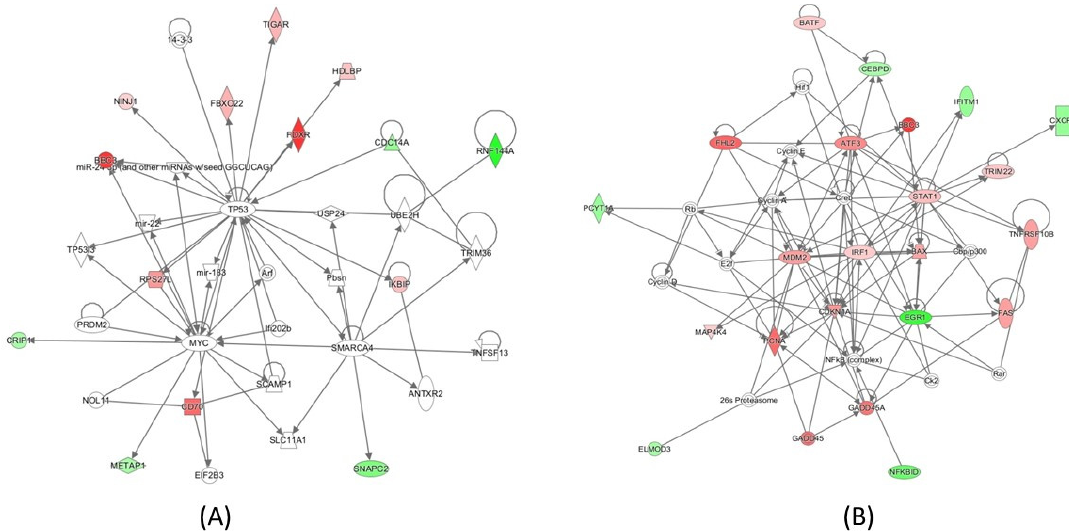
Figure 4. IPA analysis of the genes whose expressions were significantly altered when all cells were considered indicated that ( A ) TP53 is the primary response to radiation exposure in human T cells after 2 Gy gamma irradiation, and ( B ) activation of the STAT1/IRF1 signaling pathway in the irradiated